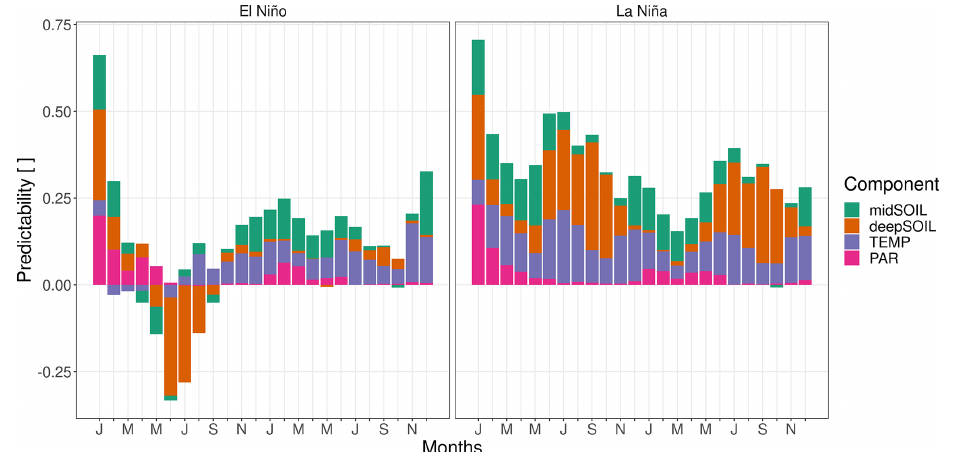
Figure 8. The composition of NPP predictability ( V c ) in the Amazon Basin by ENSO state. The contributing components are the pre- dictability of soil moisture at 19–78 and 79–268cm depth (midSOIL and deepSOIL), air temperature (TEMP), and photosynthetically active radiation (PAR). La Niña years have an overall higher predictability. Negative values mean an ensemble variance that is exceeding the climatological variance.